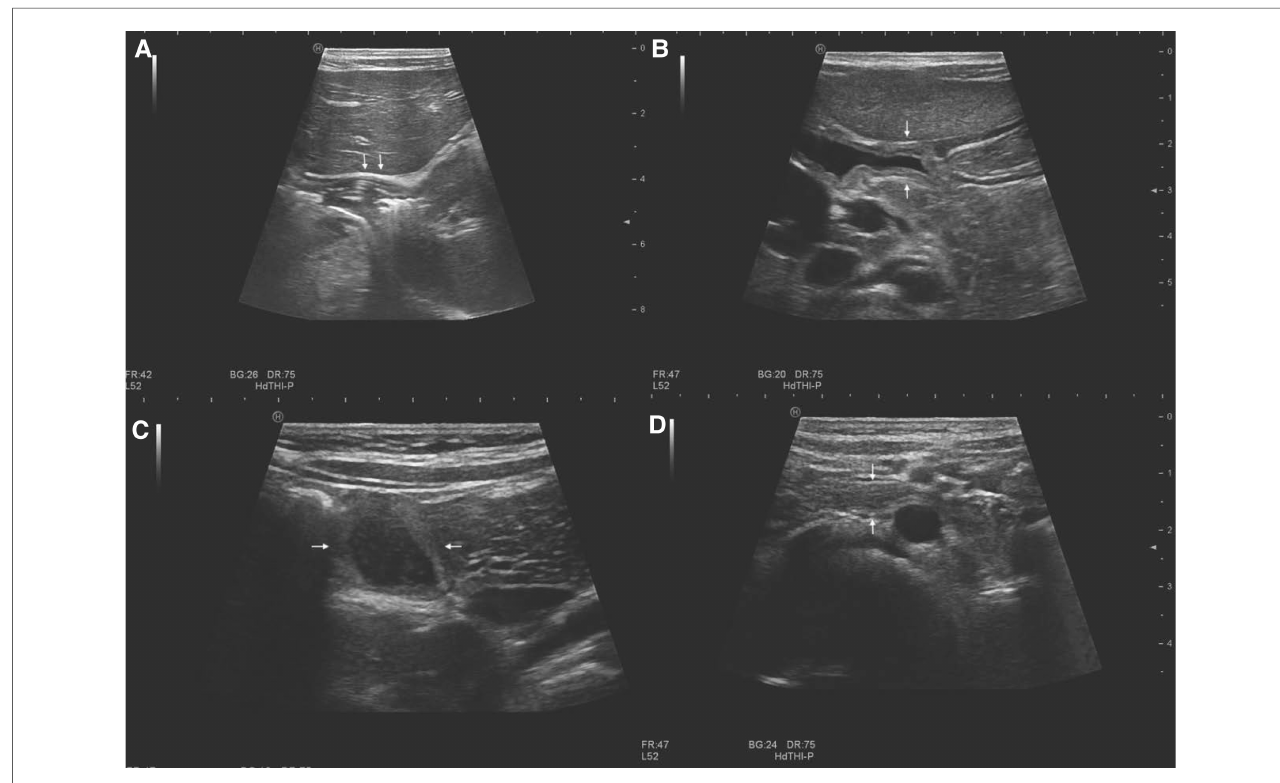
FIGURE 1 Normal gastrointestinal sonographic images obtained with high-frequency probes in a 2-year-old girl without magnets. Sonograms display the cardia (arrow in A ), duodenal bulb (arrow in B ), descending portion of duodenum (arrow in C ), and horizontal portion of the duodenum (arrow in D